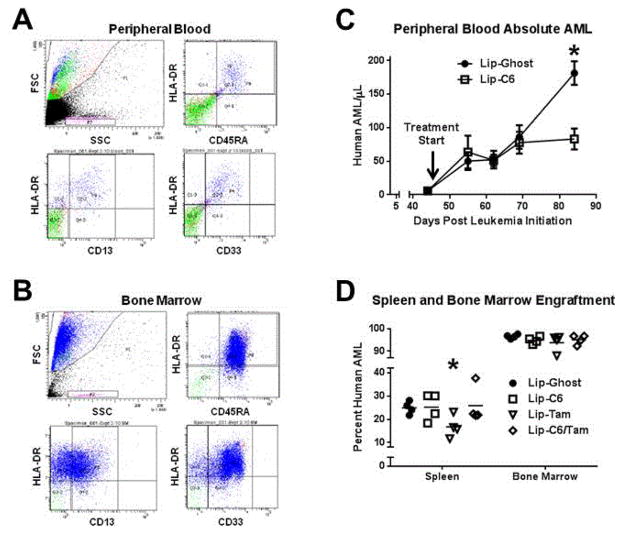
Monitoring the therapeutic efficacy of C6-ceramide and tamoxifen nanoliposomes in NSG mice engrafted with human AML. NSG mice were given sublethal total body irradiation prior to engraftment with human AML via tail vein injection. Engraftment was evaluated by flow cytometry of the peripheral blood (A), and bone marrow (B), using anti-human CD13, CD33, HLA-DR, and CD45 antibodies. (C) Treatment was initiated following engraftment confirmation, and the anti-AML efficacy of C6-ceramide nanoliposomes (Lip-C6), or control nanoliposomes (Lip-Ghost), was evaluated using NSG mice engrafted with a poor prognosis human AML sample (inv3, -7), and leukemia burden was routinely monitored by analysis of blood collected from tail vein prick. *p<0.001, 2-way ANOVA, n=4 mice per group, error bars represent standard error of the mean. (D) Human AML engraftment was assessed by flow cytometry of spleen and bone marrow preparations following necropsy at day 98. Included is a comparison with tamoxifen nanoliposomes (Lip-Tam), as well as nanoliposomes loaded with both C6-ceramide and tamoxifen (Lip-C6/Tam) (*p=0.0317, unpaired t-test comparing Lip-Ghost and Lip-Tam).